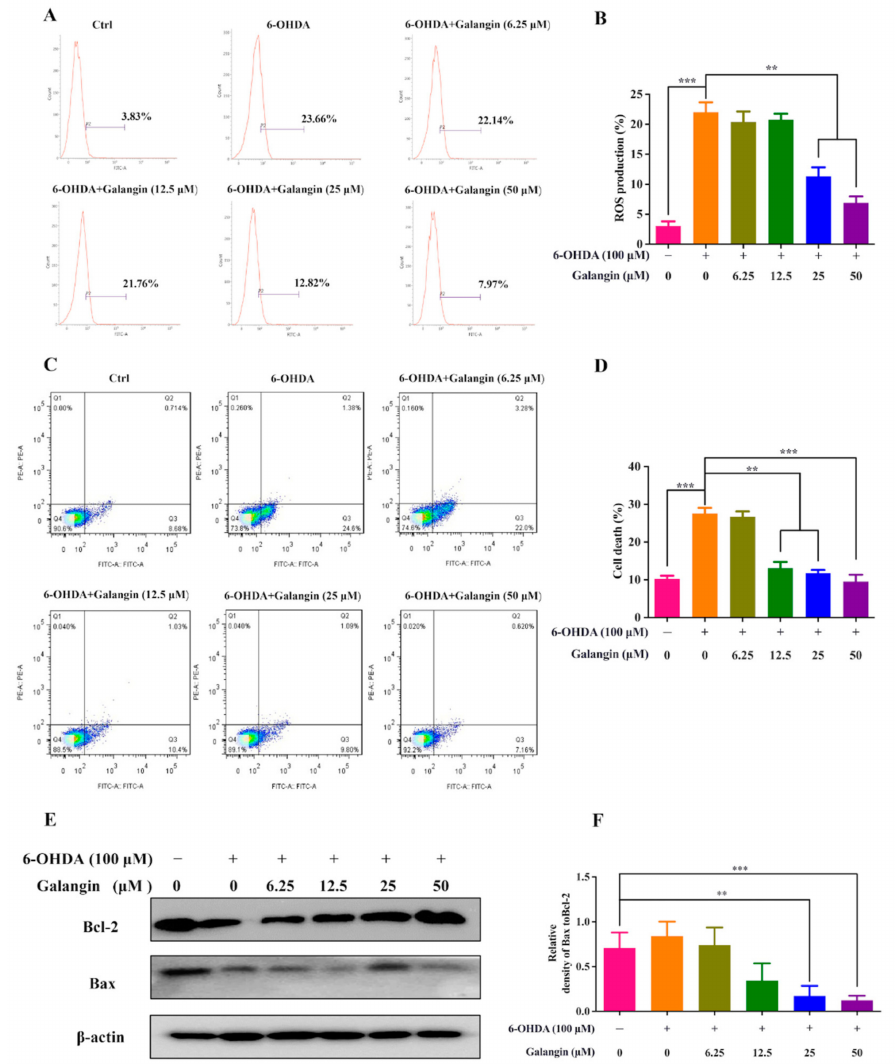
Figure 5. Galangin reduced 6-OHDA-induced intracellular ROS generation and apoptosis in HT22 cells. ( A ) HT22 cells were treated with galangin in the absence or presence of 6-OHDA at the indicated concentrations for 24 h. After treatment, the cells were incubated with 5 µ M H2DCFDA probe for 30 min and subjected to flow cytometry analysis. ( B ) Bar chart indicates the percentage of HT22 cells with H2DCFDA signals. Bars, S.D., ** p ≤ 0.01, *** p ≤ 0.001. ( C ) HT22 cells were treated with galangin in the absence or presence of 6-OHDA at the indicated concentrations for 24 h. After treatment, the cells were collected and analyzed by flow cytometry using an Annexin V-FITC apoptosis detection kit according to the manufacturer’s instructions. ( D ) Bar chart indicates the apoptosis rate of HT22 cells. Bars, S.D., ** p ≤ 0.01, *** p ≤ 0.001. ( E ) HT22 cells were treated with galangin in the absence or presence of 6-OHDA at the indicated concentrations for 24 h. After treatment, cell lysates were then collected for the protein detection of Bax, Bcl-2, and β -actin by Western blot. ( F ) Bar chart indicates the ratio of Bax/Bcl-2. Bars, S.D., ** p ≤ 0.01, *** p ≤ 0.001. The full-length Western blotting images are shown in Supplementary Figure